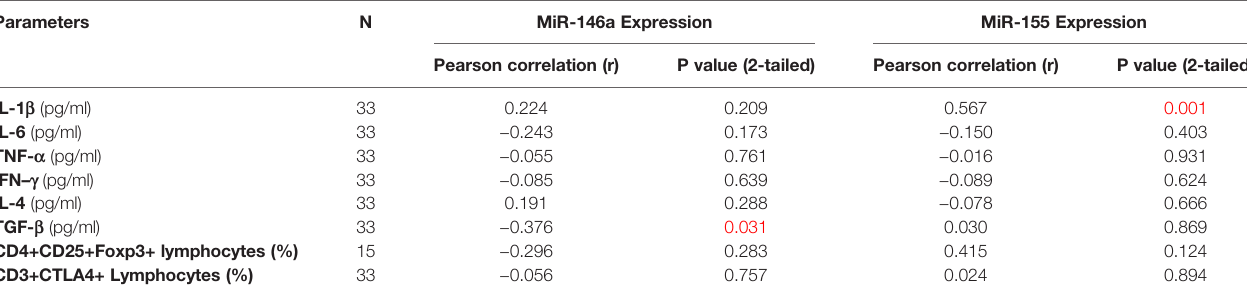
TABLE 6 | Association between miR-146a and miR-155 expression with cytokines and Treg and CD3/CTALA-4 in patients. Parameters